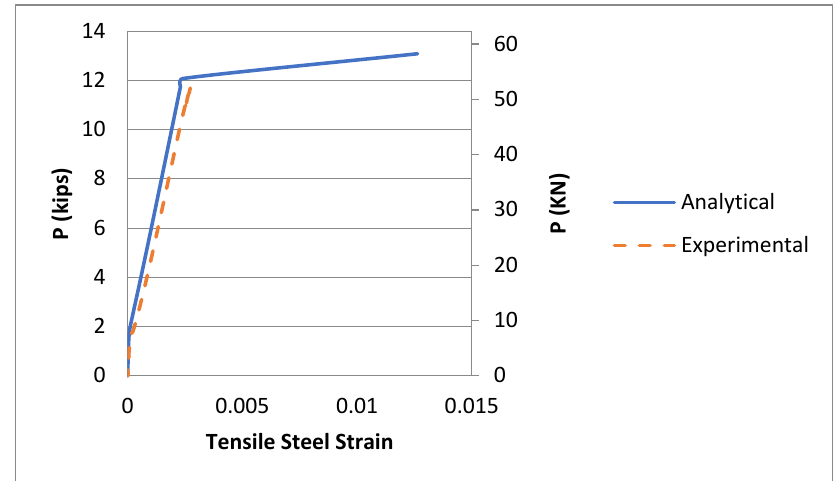
Figure 19. Decker (2007) [18] load vs. maximum compressive strain comparison.